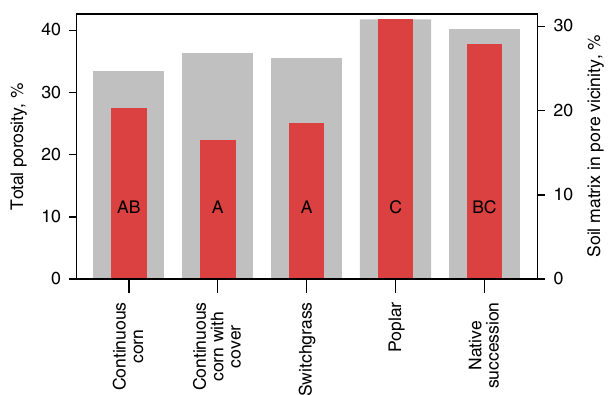
Fig. 3 Soil pore characteristics of the studied cropping systems 9 years after their implementation. Total porosity (gray bars, left y -axis) and percent of soil matrix located within <180 µ m distance from the nearest ≥ 30 µ m pore (red bars, right y -axis). Letters mark signi fi cant differences among the systems in terms of percent of soil matrix located within <180 µ m distance from the nearest ≥ 30 µ m pore ( p < 0.05). Source data are provided as